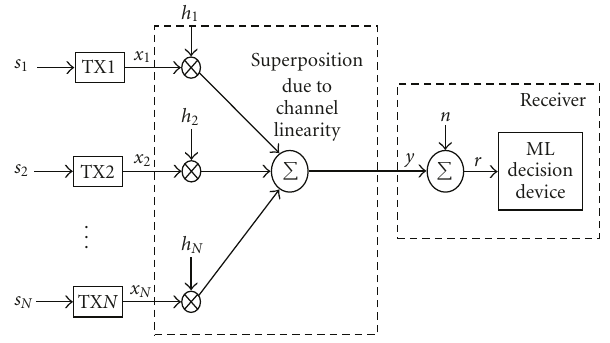
Figure 1: Baseband model of